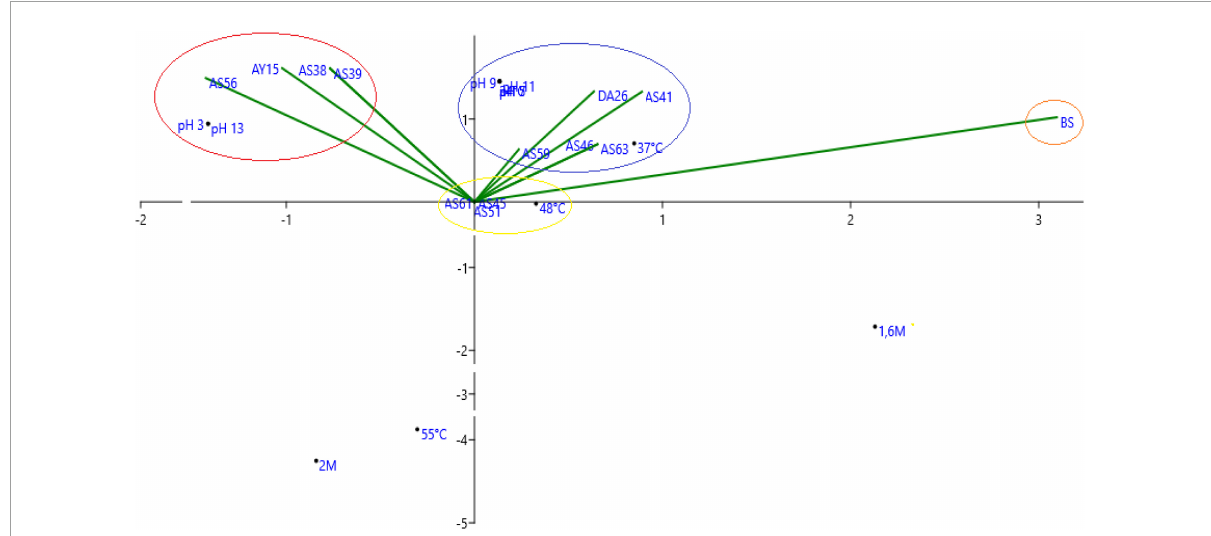
FIGURE9 Principal correspondence analysis of tested isolates on physico-chemical